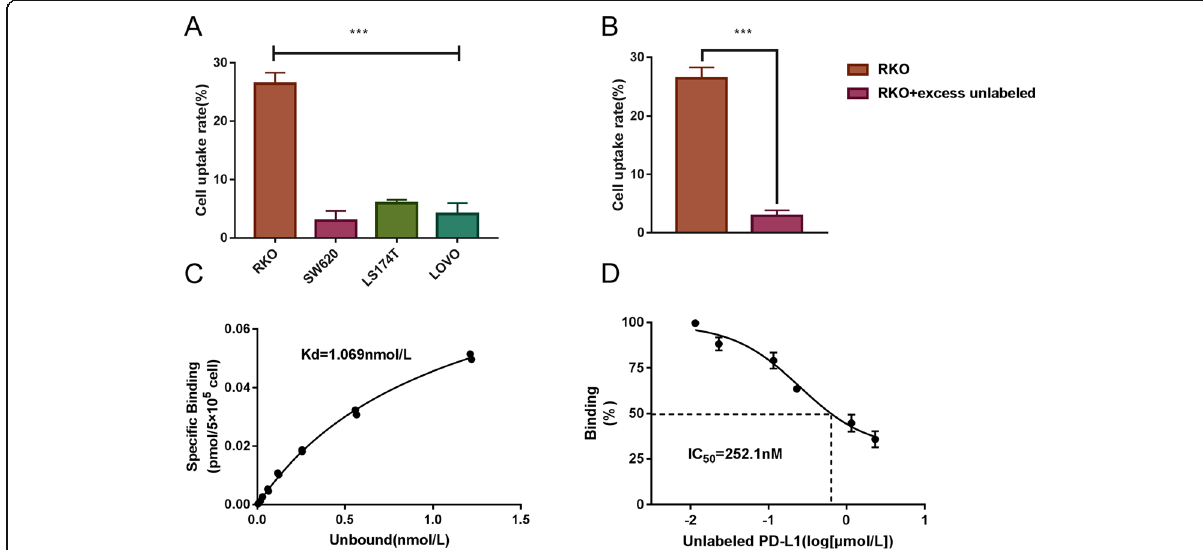
Fig. 4 Cell affinity characteristics of 131 I-PD-L1-Mab in vitro. a Cell binding of 131 I-PD-L1-Mab to four different CRC cell lines with constant concentration of 131 I-PD-L1-Mab. b Cell binding of 131 I-PD-L1-Mab to RKO with or without blocking. c Saturation binding assay of 131 I-PD-L1-Mab, Kd = 1.069 nmol/L, the number of binding sites was 113,671 ± 4183 per cell. d Competitive inhibition assay of 131 I-PD-L1-Mab showed an IC50 of